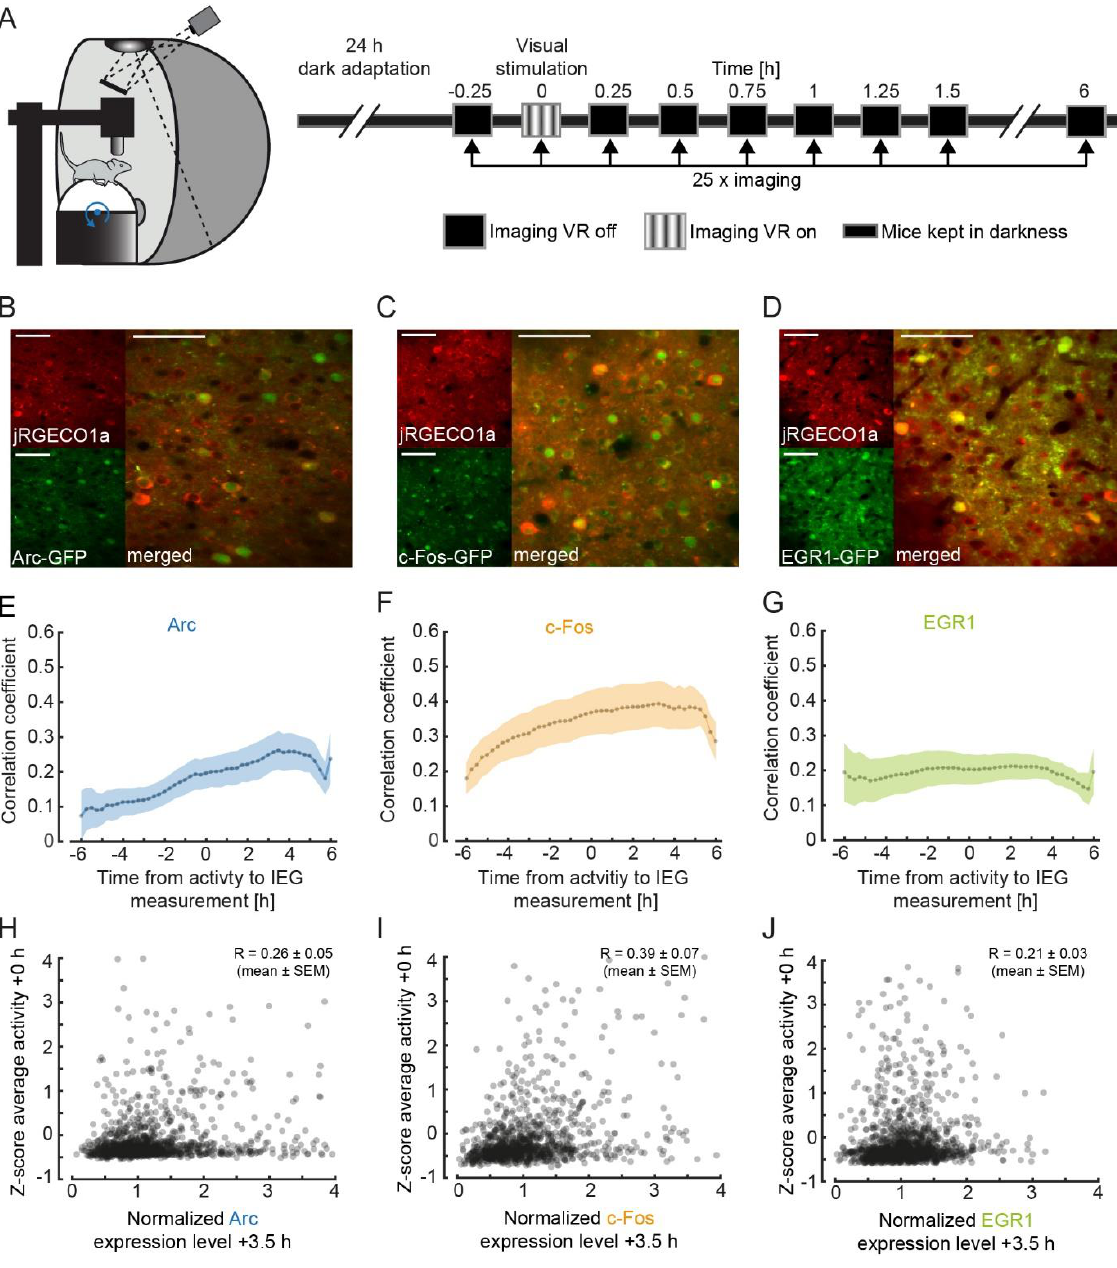
Figure 1. Simultaneous imaging of neuronal activity and immediate early gene expression in visual